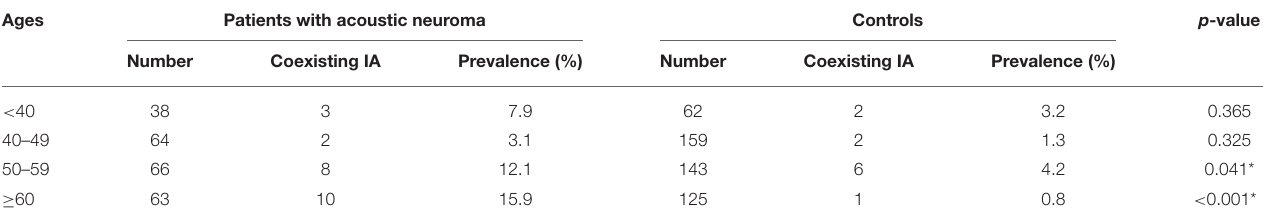
TABLE 2 | Age-matched comparison of the incidence of intracranial aneurysm in patients with acoustic neuroma and controls.